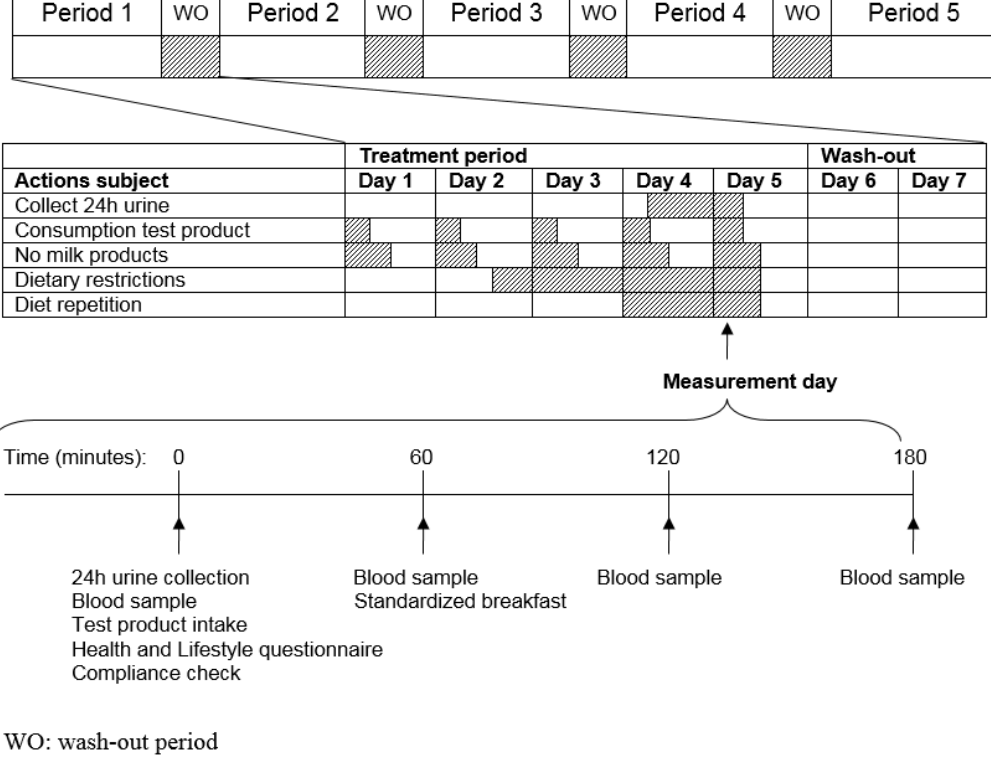
Figure 1. Study overview. In each period the subjects received one of the five treatments. Each period consisted of five days of treatment and two days of washout. On day 5, the measurement day, 24h urine was collected and venous blood was collected prior to ( t = 0) and 1, 2 and 3 h after intake of the test